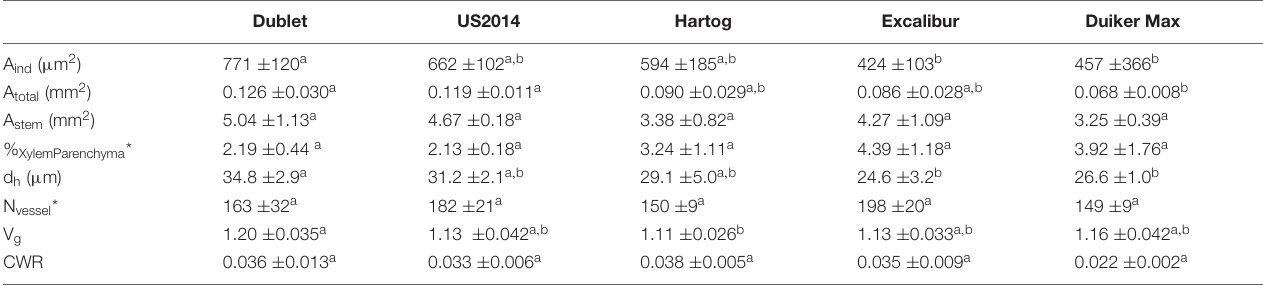
TABLE 3 | Stem anatomical parameters individual vessel area (A ind ), total vessel area (A total ), total stem area (A stem ), ratio xylem parenchyma to total stem area (%